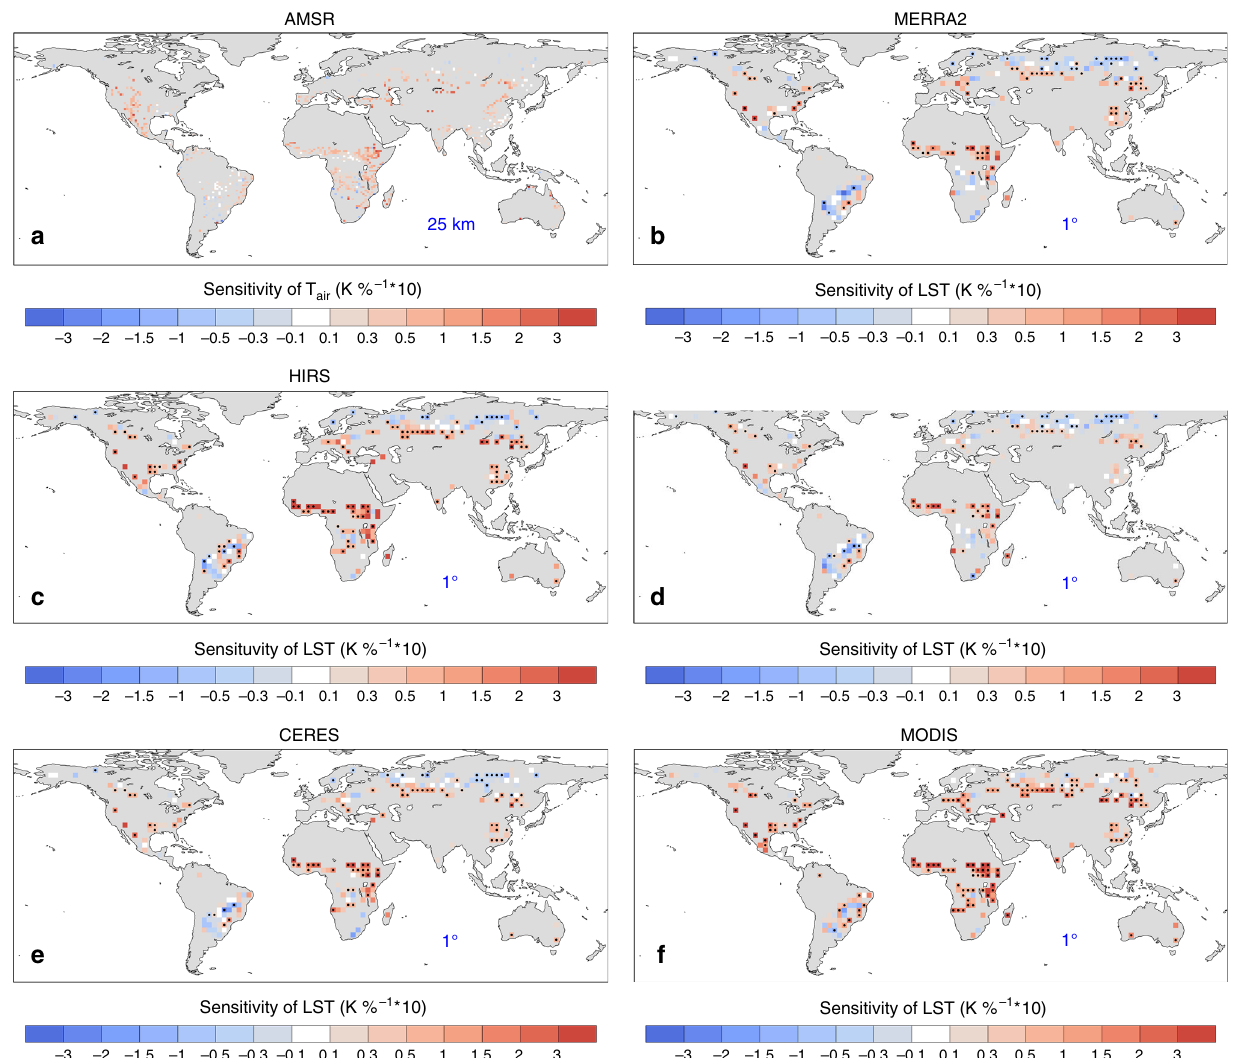
Fig. 6 Observed sensitivity of surface temperature to deforestation using different satellite and reanalysis products at different scales. a Daily maximum 2-m air temperature derived from the Advanced Microwave Scanning Radiometer-Earth Observing System and Advanced Microwave Scanning Radiometer 2 (AMSR-E and AMSR2), b land surface temperature (LST) from Modern-Era Retrospective analysis for Research and Applications, Version 2 (MERRA-2) reanalysis, c daily maximum LST from the Princeton High-Resolution Infrared Radiation Sounder (HIRS) products, d skin temperature from ERA-Interim, e LST derived from the Clouds and the Earth ’ s Radiant Energy System (CERES) upward longwave radiation, and f daytime LST aggregated from the Moderate Resolution Imaging Spectroradiometer (MODIS) LST product. Blue text shows the spatial resolutions of the temperature datasets. The AMSR surface temperature was analyzed within 125 × 125 km windows, and the other temperature datasets were analyzed within 3° × 3° windows. For panel a , the sensitivity is shown only where it is signi fi cant at a false discovery rate (FDR) adjusted p values of 0.05. The black dot signs in b – f indicate the sensitivity is signi fi cant at an FDR adjusted p values of